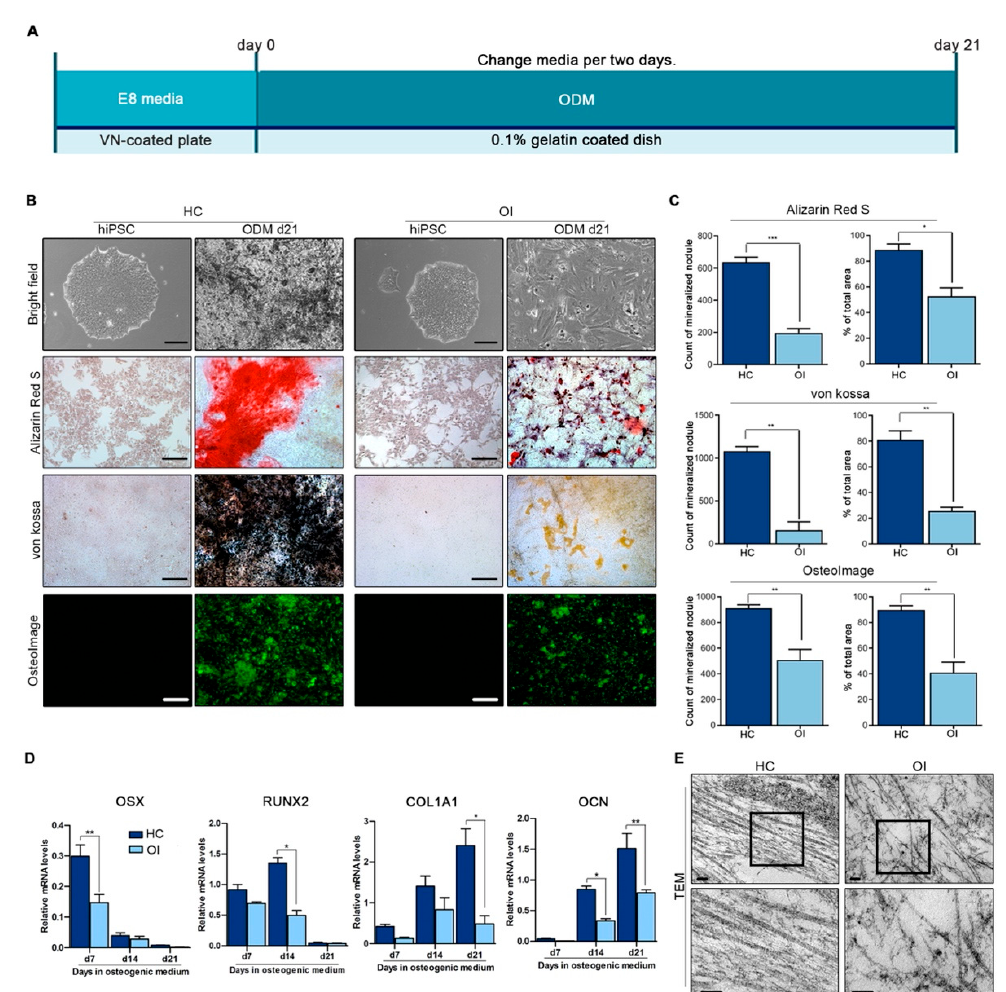
Figure 2. Reduced formation and mineralization of nodules in OI-iPSCs. Differentiation of osteoblasts from OI- and HC-iPSCs. ( A ) Schematic representation of the osteoblast differentiation protocol for OI-, HC-iPS cells by osteogenic differentiation medium (ODM). ( B ) OI-iPSCs and HC-iPSCs were cultured under osteogenic differentiation media and stained after days 7, 14, and 21 with Alizarin Red S and von Kossa to visualize calcium mineral deposition. The amount of hydroxyapatite was measured using the OsteoImage mineralization assay, in which a fluorescent green dye binds to the hydroxyapatite portion of the mineralized matrix (scale bars: 100 µ m). ( C ) Quantitative measurements of Alizarin Red S and von Kossa using ImageJ software. The amount of hydroxyapatite was measured using the OsteoImage mineralization assay and quantified using the ImageJ software. Data are means ± SEM. *** p < 0.001 vs. OI, ** p < 0.005 vs. OI, * p < 0.01 vs. OI, indicates statistical significance (Unpaired t-test). ( D ) Quantitation of expression of osteogenic marker genes (OSX, RUNX2, COL1A1, and OCN) in OI-iPSCs after 7, 14, and 21 days of osteogenic differentiation. The graphs show the mean values ± standard deviation of three independent experiments. Data were statistically analyzed using a one-way ANOVA. * p < 0.05; ** p < 0.01. ( E ) Decrease in collagen production due to abnormal changes in the structure of type I collagen, as confirmed by